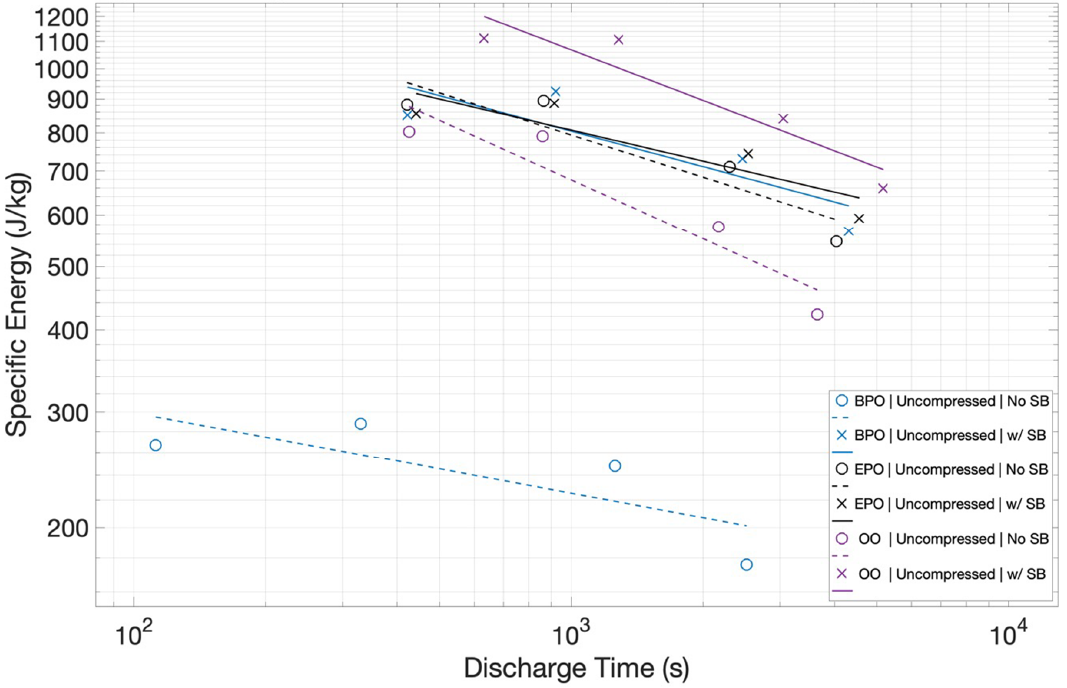
Figure 7. Impact of Salt Bridge on Specific Energy . The use of a salt bridge (solid lines) improves performance for all three configurations. More significantly, it ‘collapses’ the differences in energy density as a function of configuration.